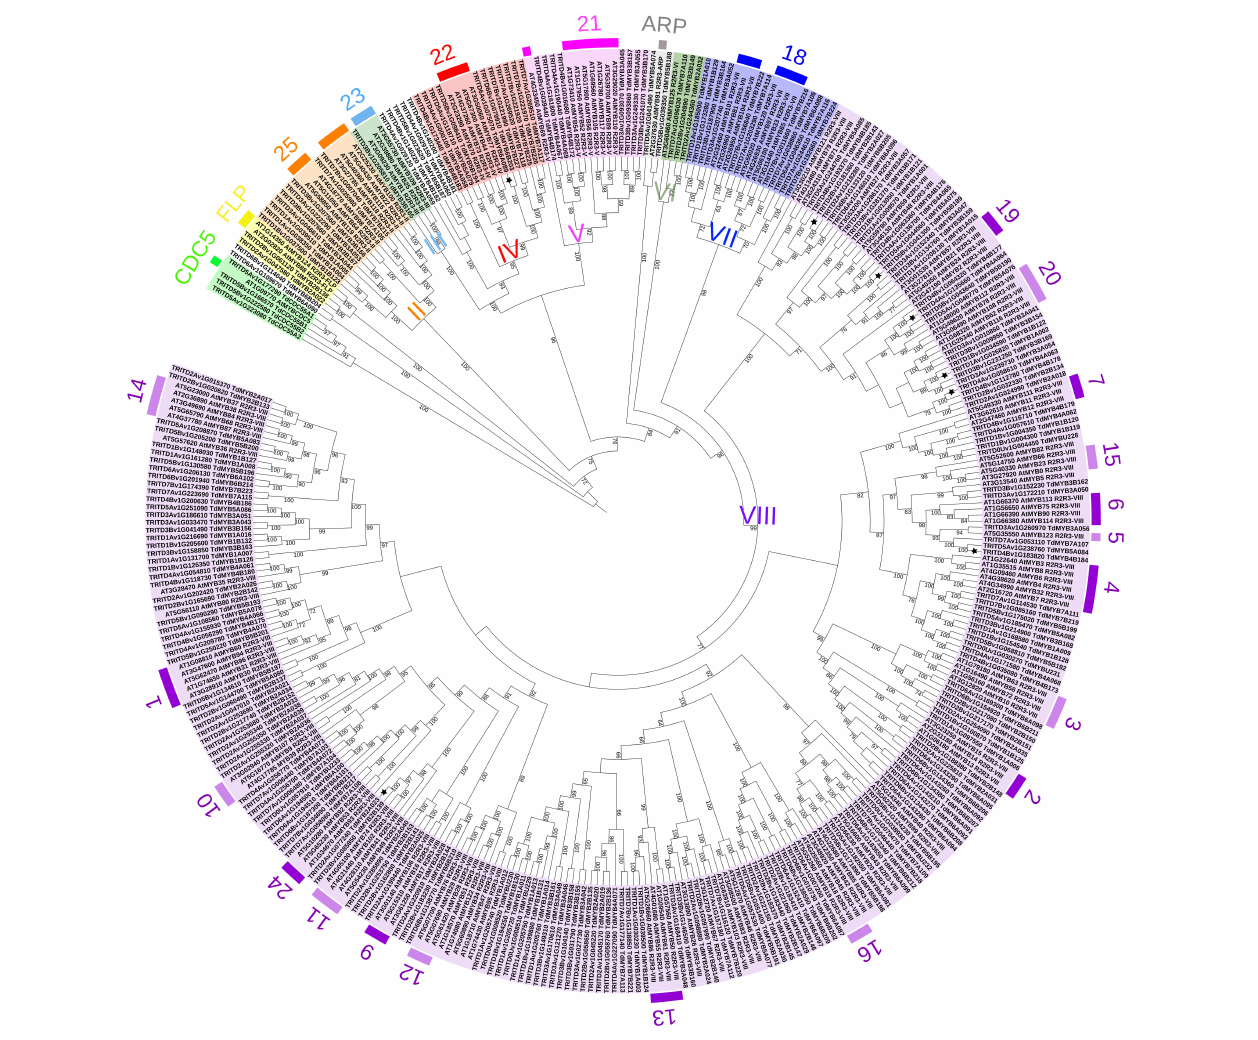
FIGURE 2 | Phylogenetic analysis of R2R3-MYB proteins from durum wheat and Arabidopsis thaliana . Maximum Likelihood tree of 237 durum wheat (TRITD-TdMYBs) and 127 Arabidopsis (AtMYBs) R2R3-MYB TFs. The tree is rooted with CDC5 sequences. Roman numbers indicate phylogenetic groups according to Jiang and Rao, 2020; external, colored numbers refer to Arabidopsis functional clusters according to Stracke et al. (2001) and Dubos et al. (2010). Stars are referred to the MYBs analyzed by means of qPCR. Numbers on the branch nodes indicate bootstrap values (only bootstraps > 60 are